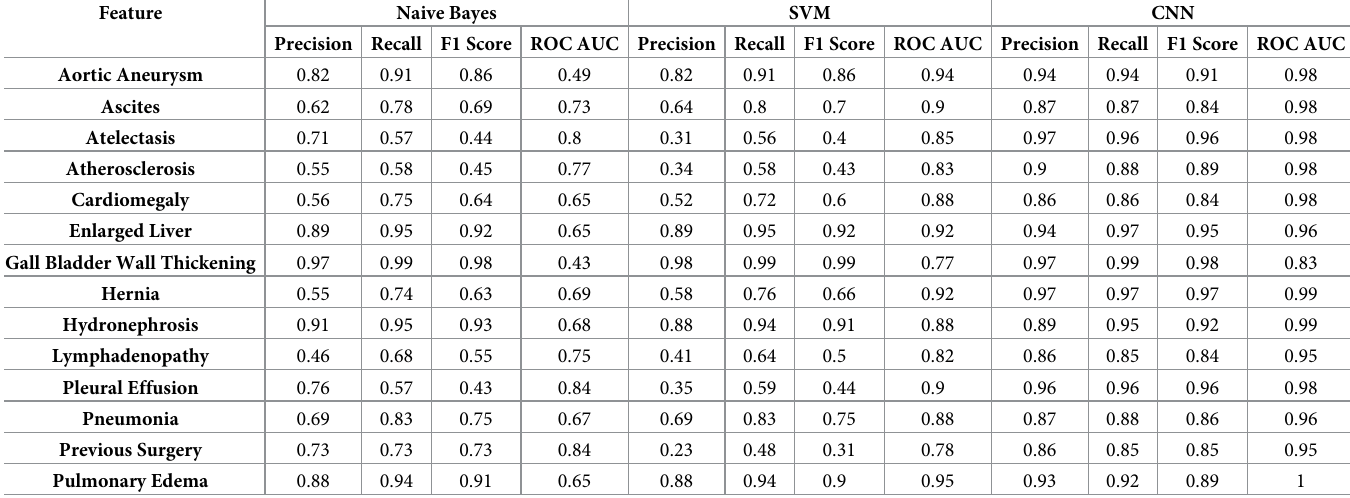
Table 2. Performance of the Convolutional Neural Network (CNN) model benchmarked against machine learning algorithms for the extraction of 14 pre-selected radiographic findings. Feature Naive Bayes SVM